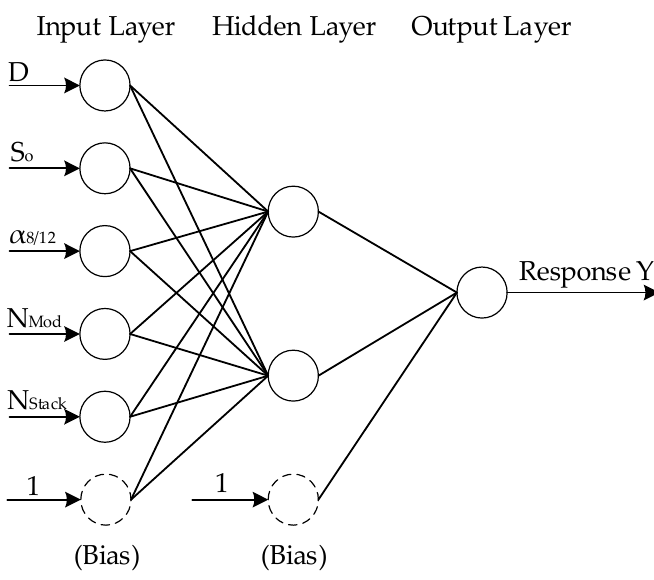
Figure 3. Architecture of the artificial neural network (ANN) used for the modelling of the four objectives and eight initial species concentrations of the integrated fermentation–membrane pervaporation system.